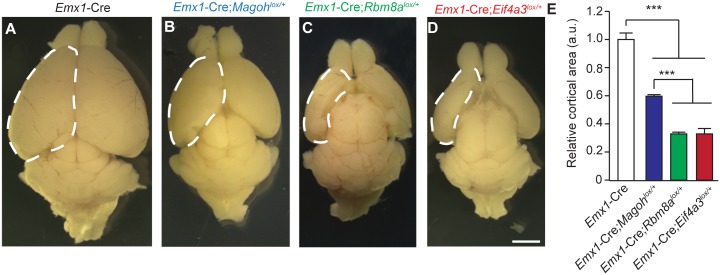
Haploinsufficiency of EJC components causes microcephaly.(A-D) Images of whole mount brains at P12 from indicated genotypes. Dotted lines denote dorsal cortex. (E) Quantification of relative dorsal cortical area in P12 brains of indicated genotypes. The area of Emx1-Cre brains was set to 1.0. ANOVA with Tukey posthoc, ***, p<0.001, Error bars, S.D. n = 3–4 biological replicates, Scale bar, A-D, 2 mm.